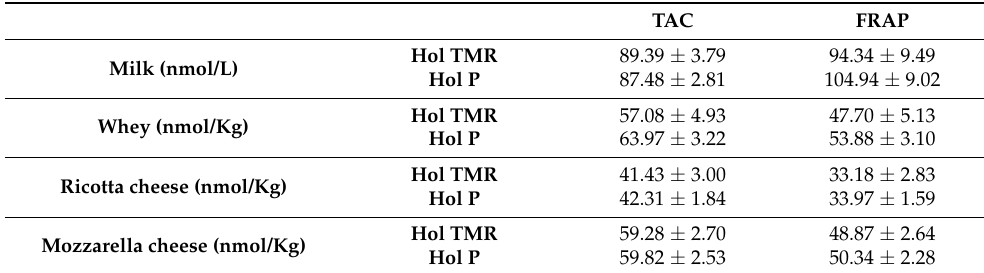
Table 4. Effect of feeding system on antioxidant activity in milk and dairy products. The pairwise contrast involved Holstein (Hol) fed total mixed ratio (TMR) and pasture